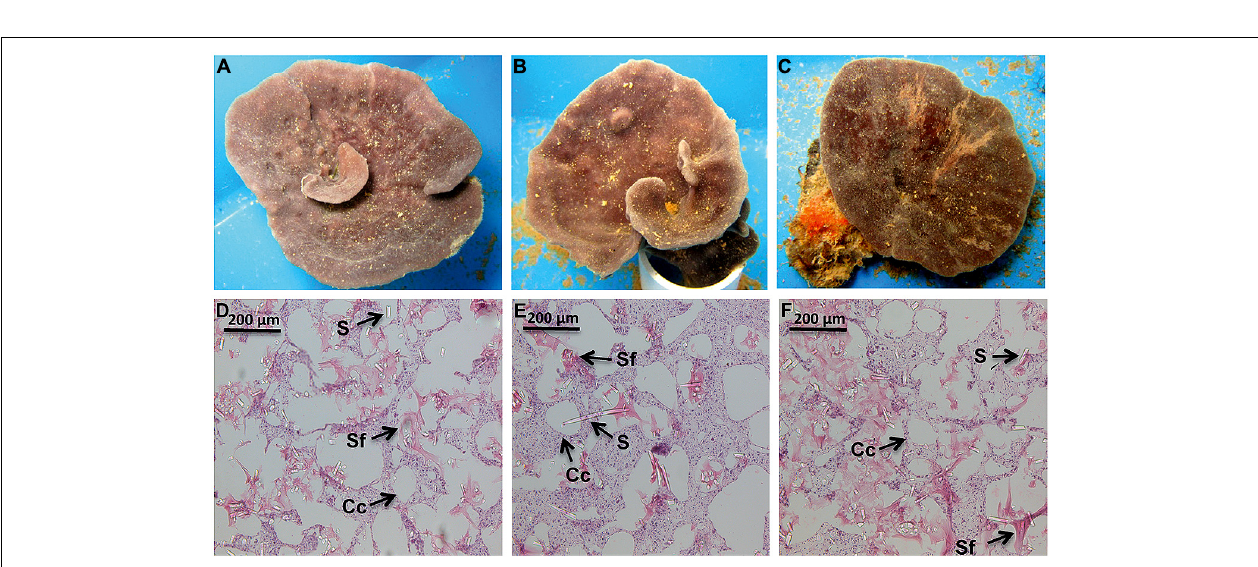
FIGURE 1 | Representative images, both external and internal, of C. stipitata from the day 0 control (A,D), T = 2, High (B,E) and T = 7, High (C,F). A representative choanocyte chamber (Cc), sponge fiber (Sf), and spicule (S) are depicted.